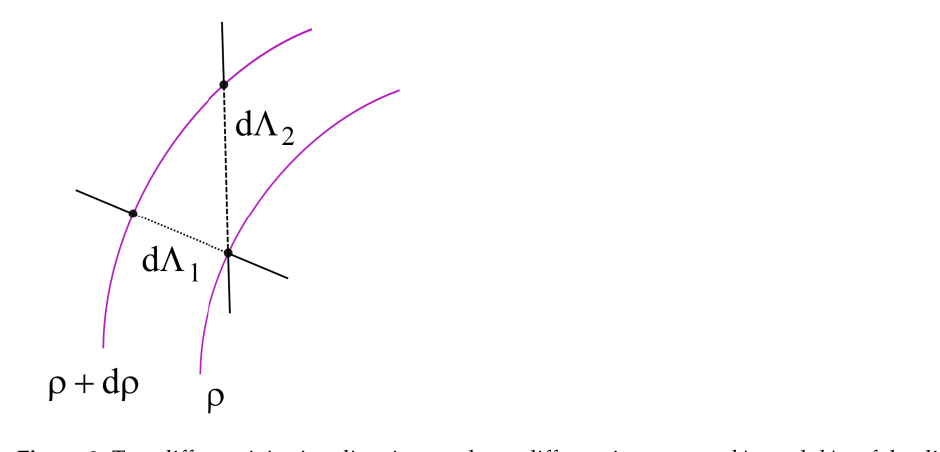
d  and d  of the 1 2